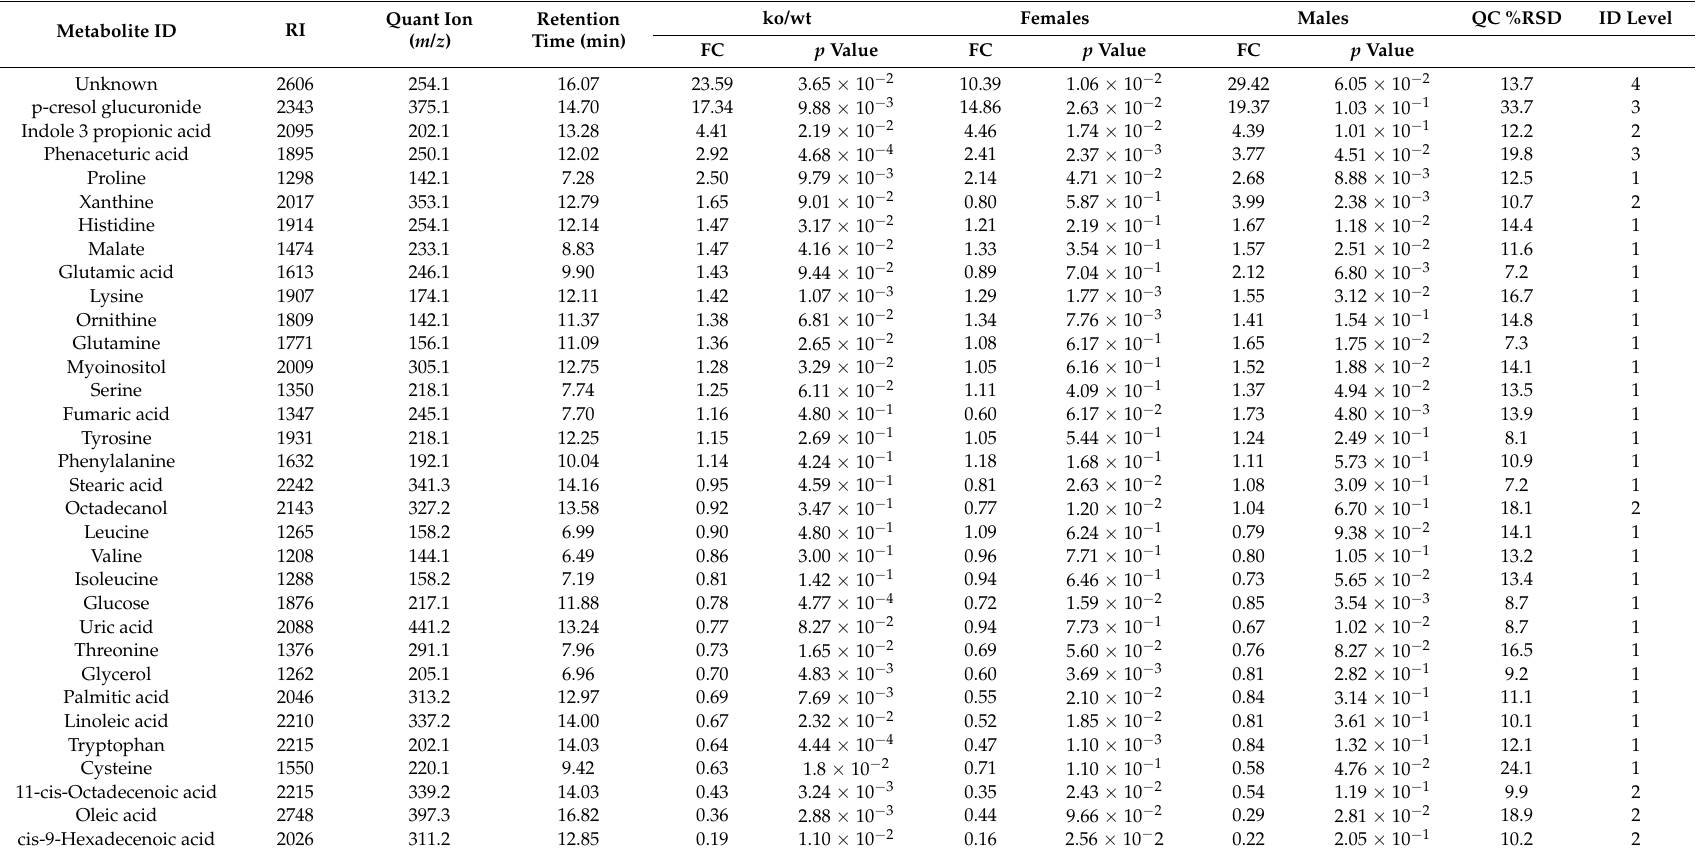
Table 5. Metabolites changes in the plasma of SLC6A19ko and SLC6A19wt